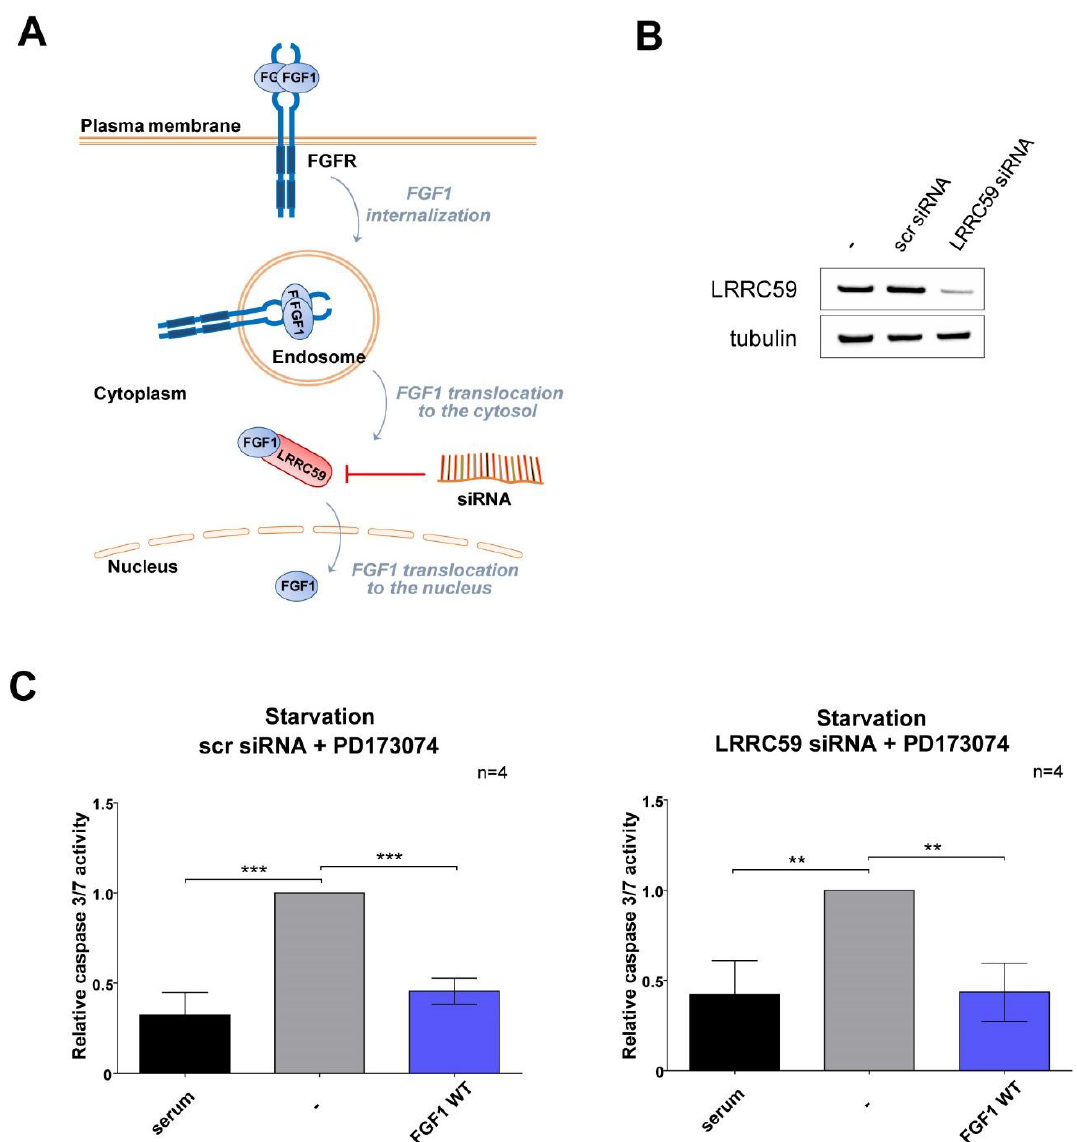
Figure 3. Protective effect of exogenously administrated FGF1 upon LRRC59 silencing. ( A ) Schematic of mediation of FGF1 nuclear translocation by LRRC59. ( B ) U2OSR1 cells were transfected with 100 nM of scramble siRNA or siRNA targeted LRRC59. The efficiency of LRRC59 silencing after 72 h was assessed by Western blotting. ( C ) For induction of apoptosis 72 h after silencing, cells were serum starved for 24 h, and then treated with wild-type FGF1 in the presence of FGFR inhibitor (100 nM PD173074). 16 h later, relative caspase 3/7 activity was determined. Data were normalized to control values and presented as means ± SD of four independent experiments. Statistical significance: ** p ≤ 0.01, *** p ≤ 0.001.